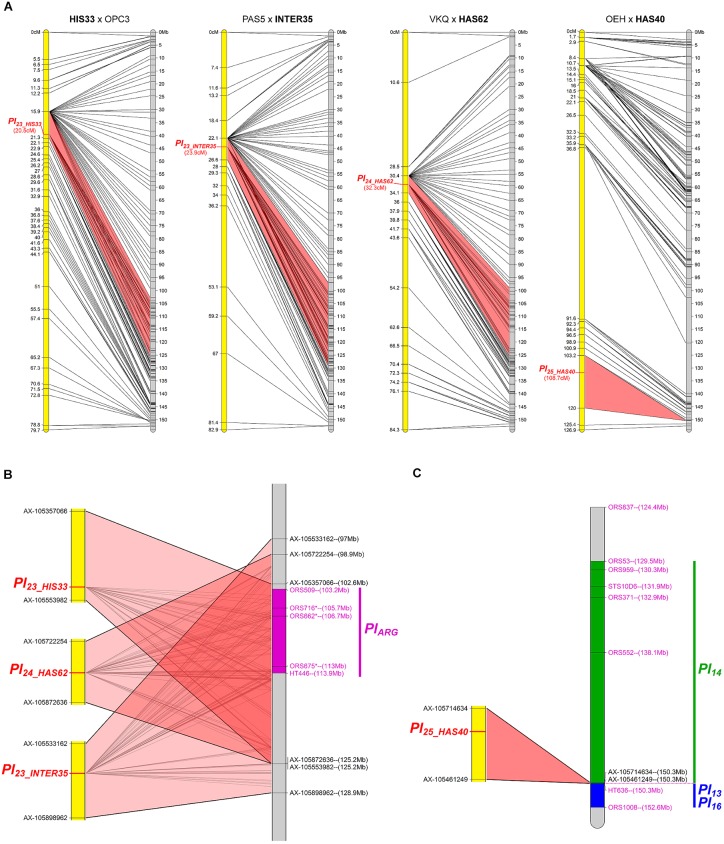
Four downy mildew resistances map to chromosome 1 of sunflower. (A) Genetic (yellow) and physical (gray) maps of the Pl23_HIS33, Pl23_INTER35, Pl24_HAS62, and Pl25_HAS40 resistance genes on chromosome 1. The cross used to map the resistance is indicated on top of each map, with the resistant parent in bold. Only the non-redundant SNP markers are indicated with their genetic (left map) and corresponding physical positions on the XRQ genome (right map). (B) Enlarged view of the physical map showing the localization of Pl23_HIS33, Pl23_INTER35, and Pl24_HAS62 genes. The chromosomal region where PlARG was located (Wieckhorst et al., 2010) is indicated in purple on the physical map. The polymorphic SNP markers of the sunflower AXIOM® array denominated AX-xxxxxxxxx are indicated with their physical positions on the sunflower genomic sequence. (C) Enlarged view of the physical map showing the localization of Pl25_HAS40 gene. Pl14, Pl13, and Pl16 resistance genes were localized according to published linked genetic markers (Mulpuri et al., 2009; Bachlava et al., 2011; Liu et al., 2012).